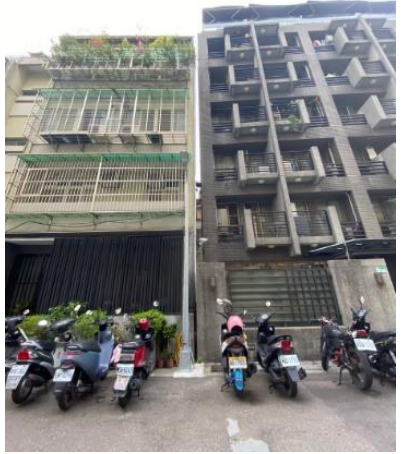
Figure 22. The image of two different townhouses with a gap.